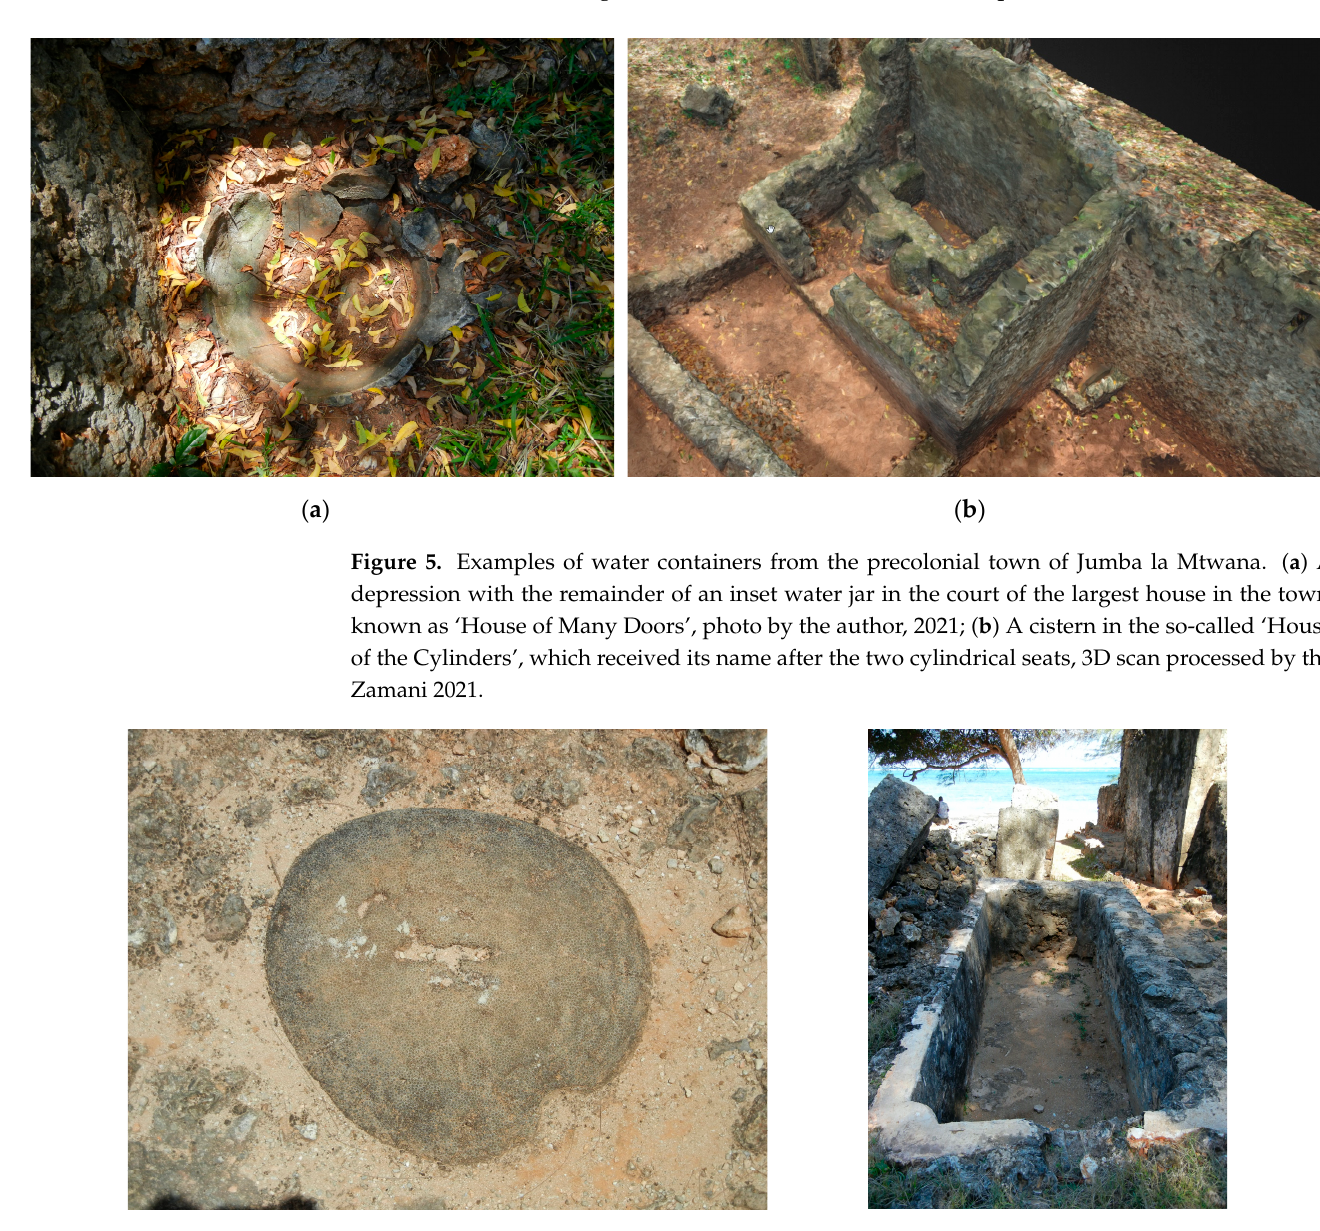
( b ) Figure 4. Examples of some types of wells in the precolonial town of Jumba la Mtwana, Kenya. Photos by the author, 2021. ( a ) A well near the center of the town. ( b ) An example of a well found by the houses.